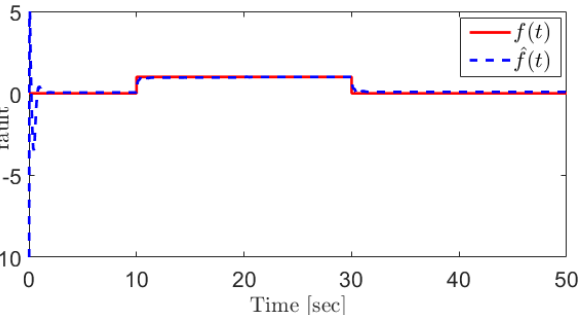
Figure 4. The EGR mass flow rate sensor fault and its reconstruction using the proposed SOSMO